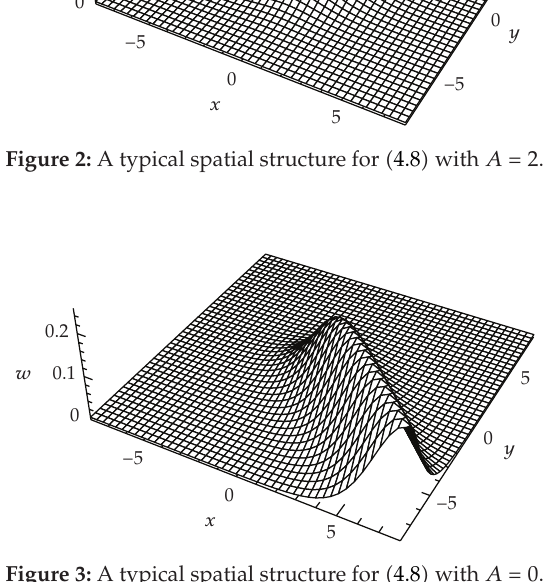
Figure 3: A typical spatial structure for (cid:2) 4.8 (cid:4) with A (cid:8)